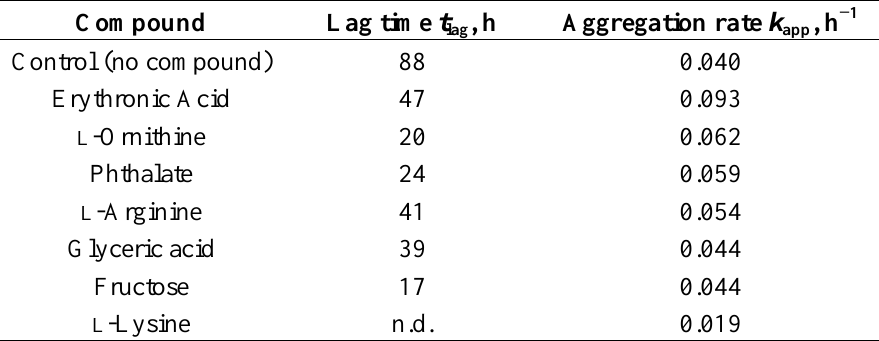
Table 2. Kinetic data from ThT SOD1 aggregation